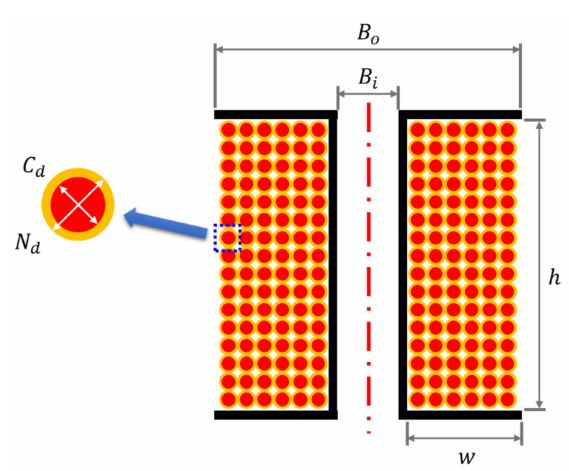
Figure 7. Schematic of the magnetic coil